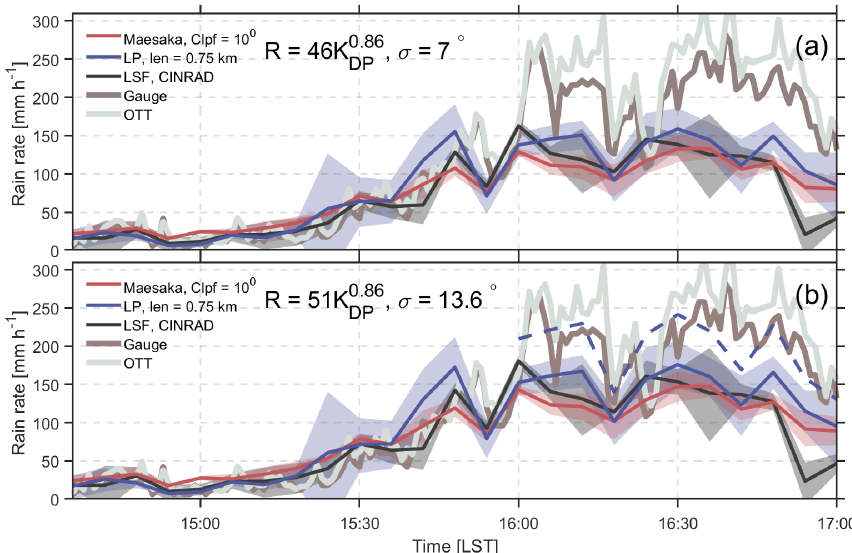
Figure 5. Comparison of rainfall estimates using K DP estimated via different methods over the Zhengzhou national reference climatological station. Thick lines and shaded areas indicate the respective median values and standard deviations of rain rates estimated from K DP at elevation angles of 1.5, 2.4, 3.3, and 4.3 ◦ . The parameterizations used are (a) R = 46 K 0 . 86 and (b) R = 51 K 0 . 86 . The dashed line in DP DP panel (b) presents the use of R = 70 K 0 . 86 ( σ = 24 . 7 ◦ ) for QPE from 16:00 to 17:00LST. DP